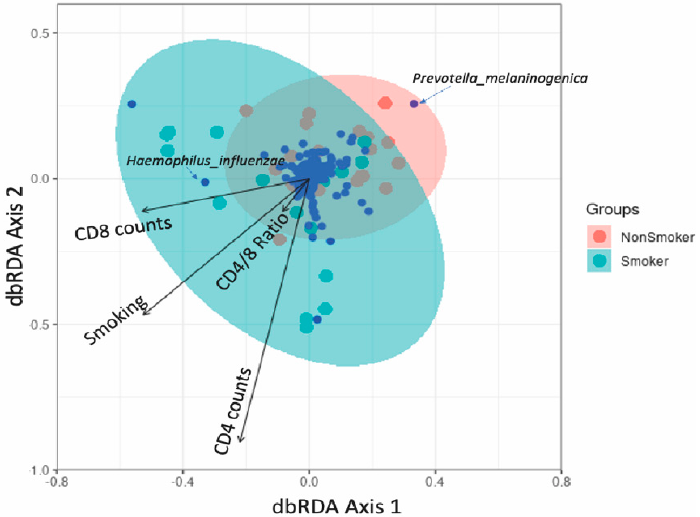
Figure 5. Distance-based redundancy analysis (dbRDA) on the lung bacterial community composition with explanatory variables of (CD4+ and CD8+ counts. Hellinger-transformed community data was ordinated as circles of either pink (nonsmoker) or cyan (smoker) and bacterial ASVs were pre- sented as the small blue circles. The arrows represent the influence of constraining variables on bacterial communities where a small angle between two arrows indicated a similar influence of the two constraints on community composition. The relative position of arrows relative to the blue points (bacterial ASVs) suggests the impact of constraints on the abundance of ASVs and blue points near to the arrow line in the same/opposite direction indicates positive/negative impacts, e.g., Prevotella melaninogenica is located nearly opposite to the smoking arrow, suggesting that smokers have less Prevotella melaninogenica relative to non-smokers. 37 samples were included.